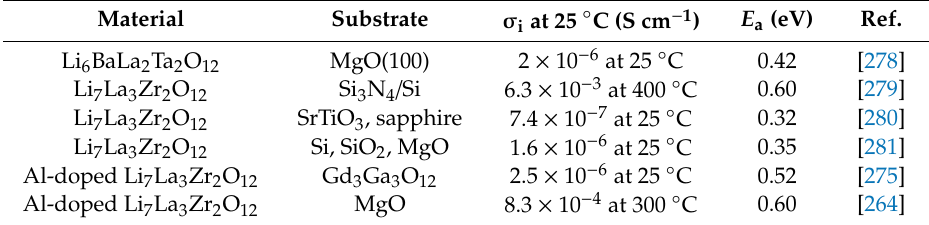
Table 9. Literature review of garnet-like solid electrolyte thin films grown via